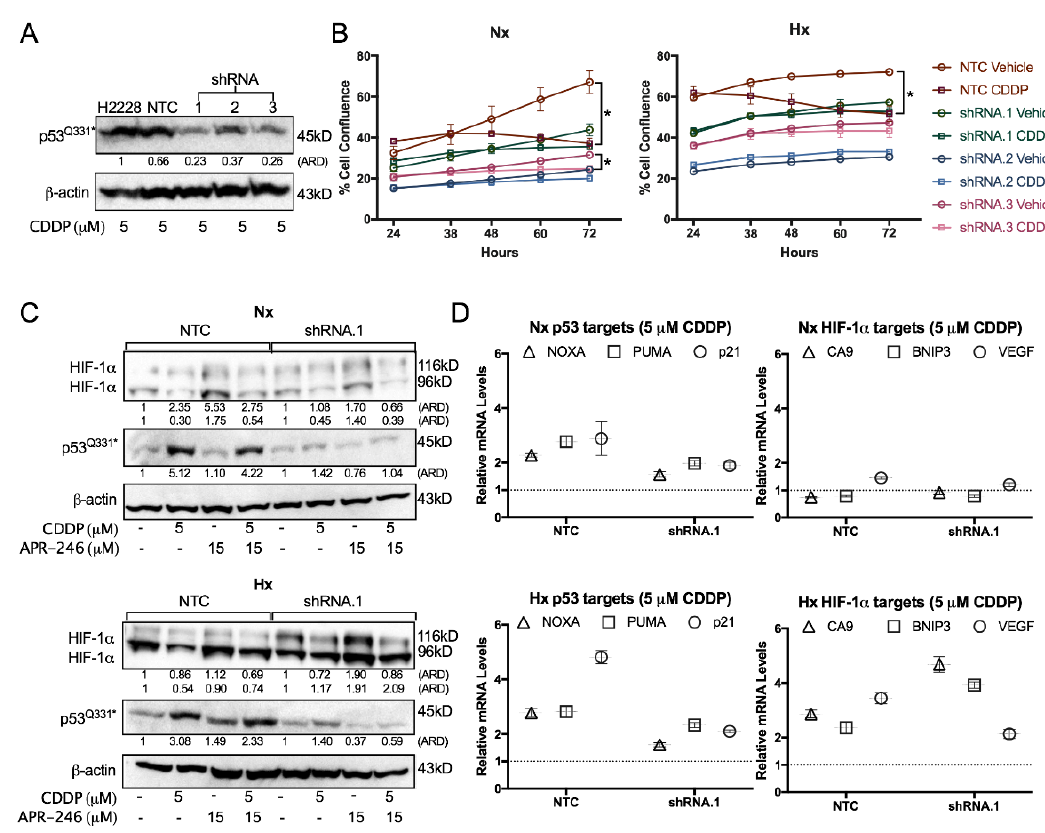
Figure 4. Role of p53 in CDDP resistance. ( A ) P53 protein levels determined by Western blotting after 48 h treatment with 5 µM CDDP of the NCI-H2228 Q331 * parental cell line, nontemplate control (NTC), and three TP53 shRNA monoclonal subclones under normoxia. β-actin was used as an internal standard. ( B ) Cell proliferation presented as mean ± SD of 3 replicates Green Object Confluence using the IncuCyte system. Cells were treated with either vehicle or 5 µ M CDDP under normoxia or 1% O 2 . ( C ) Protein levels of HIF-1 α 116 kDa (processed), HIF-1 α 96 kDa (unprocessed), and p53 were determined by Western blotting after treatment with vehicle, CDDP, APR-246, or combination therapy for 24 h in NTC and shRNA.1 ( TP53 shRNA) cell lines under normoxic and hypoxic conditions. β -actin was used as internal control. ( D ) mRNA levels of p53 (NOXA, PUMA, p21) and HIF-1 α (CA9, BNIP3, VEGF) transcription targets. NTC and shRNA.1 cells were treated with 5 µ M CDDP for 24 h under normoxia or 1% O 2 and expression levels are presented relative to the vehicle-treated sample under normoxia. (* p < 0.05 compared to vehicle-treated sample at the 72 h time-point). ARD: Adjusted Relative Density; Nx: normoxia; Hx: hypoxia.